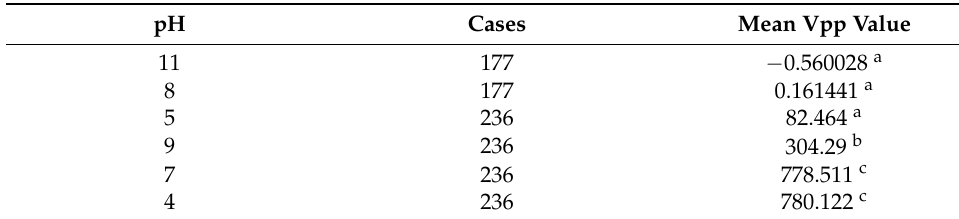
Table 8. Duncan’s Multiple Range Test for pH of Two-Way ANOVA results for the delay with all gathered data.